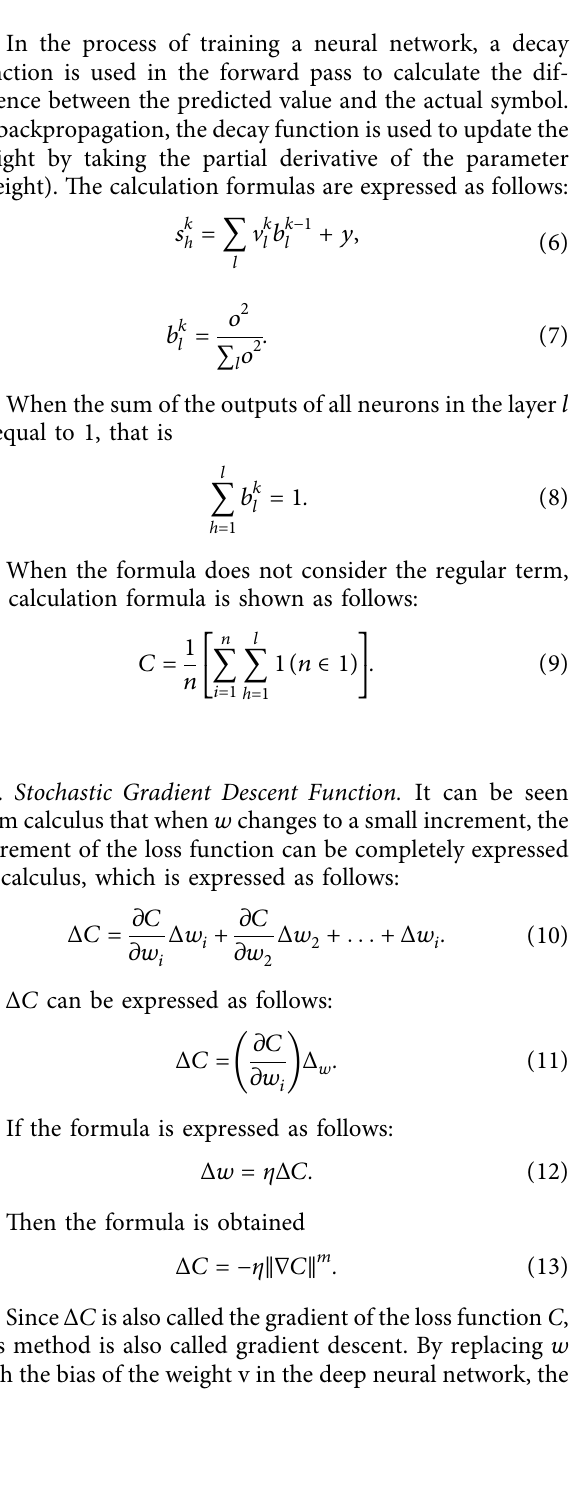
Figure 4: The CNN network